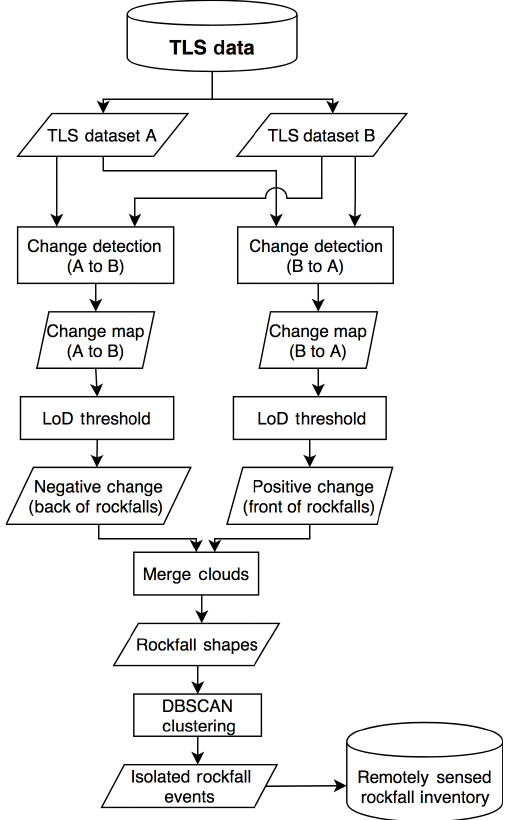
Figure 5. Structured flow chart of the semi-automated process of extracting rockfall from sequential TLS